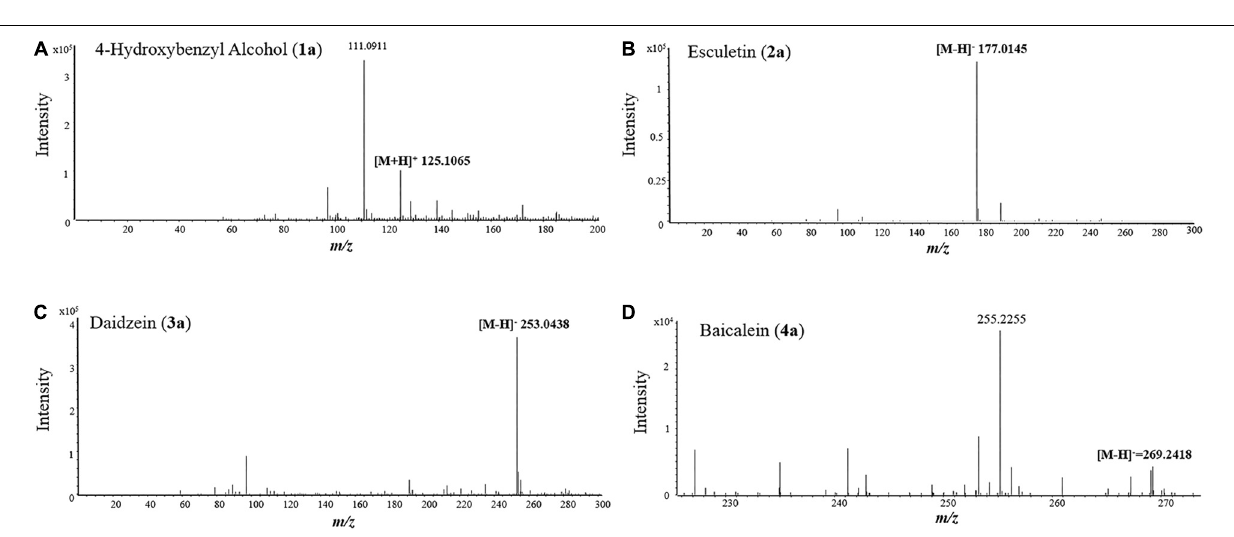
FIGURE 6 | MS spectra of 4-hydroxybenzyl alcohol (A) , esculetin (B) , daidzein (C) , and baicalein (D)